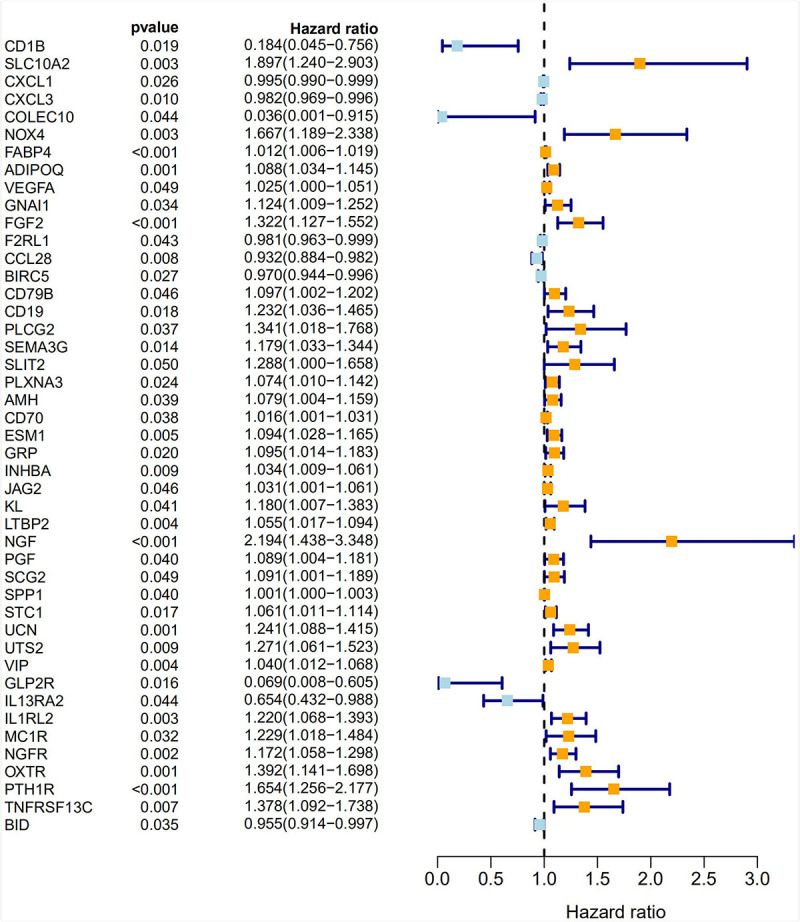
Forest plot of 45 prognostic immune-related DEGs in CRC. Hazard ratios (HR) and corresponding 95% confidence intervals (CI) were estimated using the univariate Cox regression model. The orange modules represent high-risk genes and the light blue modules represent low-risk genes in CRC.